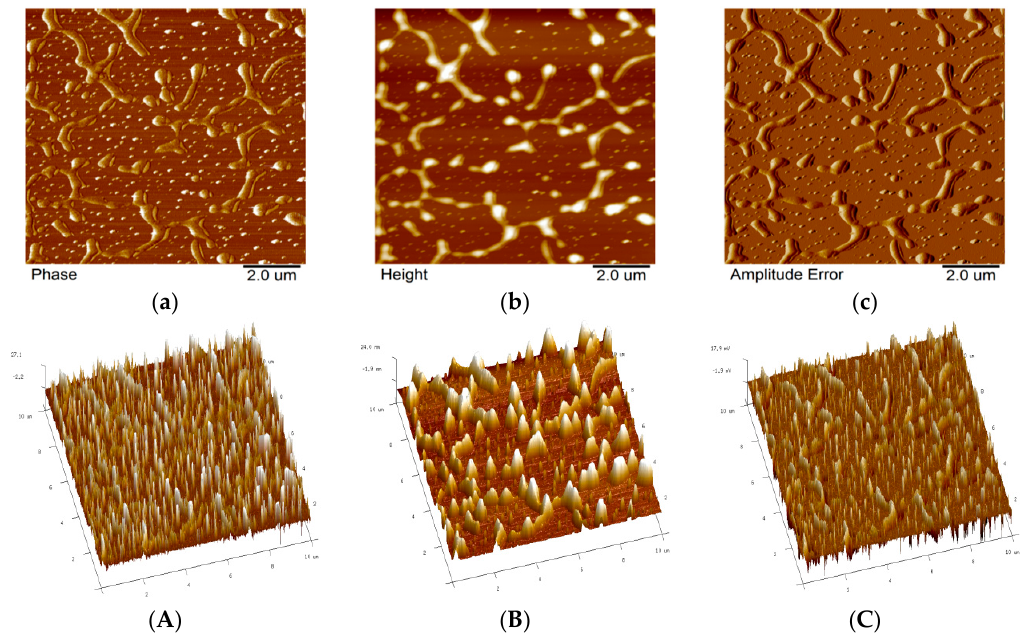
Figure 5. Atomic force microscopic images of BTPU. ( a ) 2-D phase image, ( b ) 2-D height image, ( c ) 2-D amplitude error image. ( A ) 3-D phase image, ( B ) 3-D height image, and ( C ) 3-D amplitude error image.